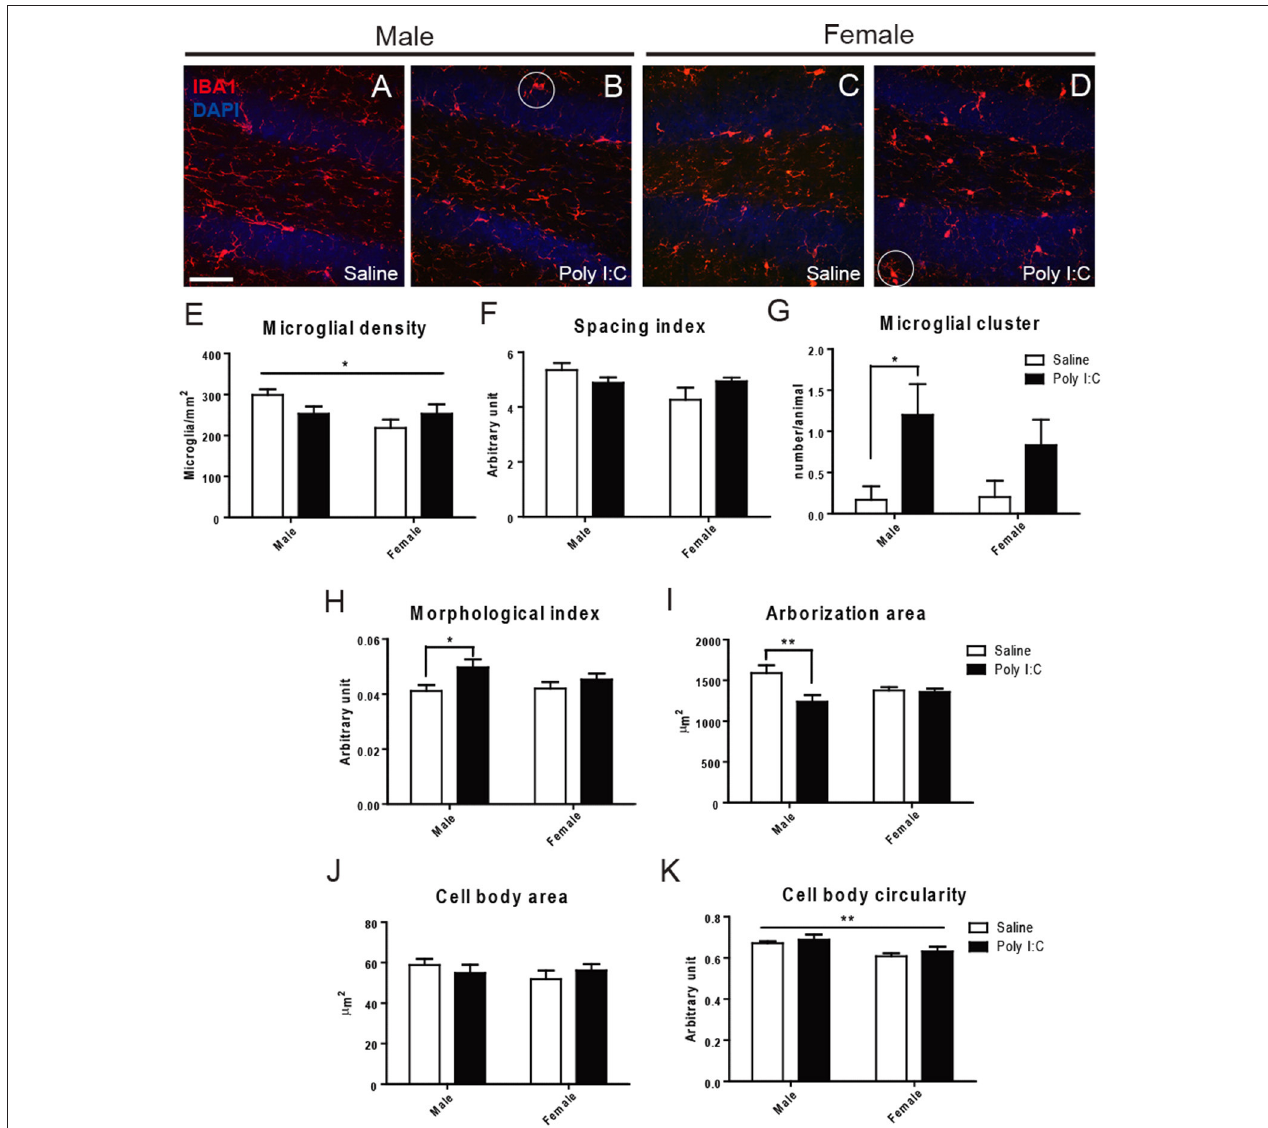
FIGURE 1 | Effects of Poly I:C on microglial distribution and morphology in hippocampal DG. (A–D) Low magnification (20x) pictures showing the density of IBA1-stained microglial cells. Examples of clustering are encircled in (B,D) . (E–K) Microglial density, spacing index, clustering, morphological index, arborization area, cell body area, and cell body circularity are shown. In (E,K) , the asterisk refers to comparison between sexes. n = 5–6 mice per sex and group. Scale bar: 50 µ m. * p < 0.05, ** p < 0.01.